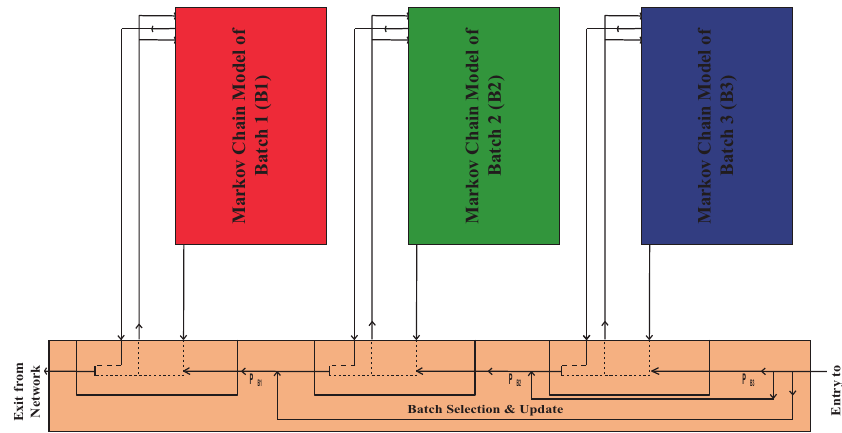
Figure 3. Channel access mechanism of proposed SAFE-MAC